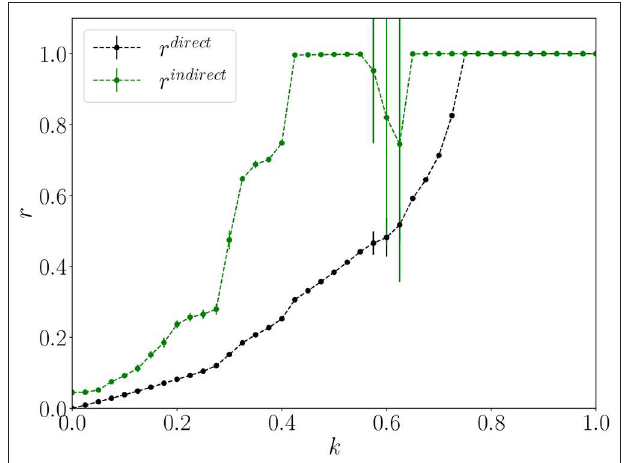
FIGURE 5 | Network 1. Mean and standard deviation of r direct (black) and r indirect (green) as a function of the coupling k